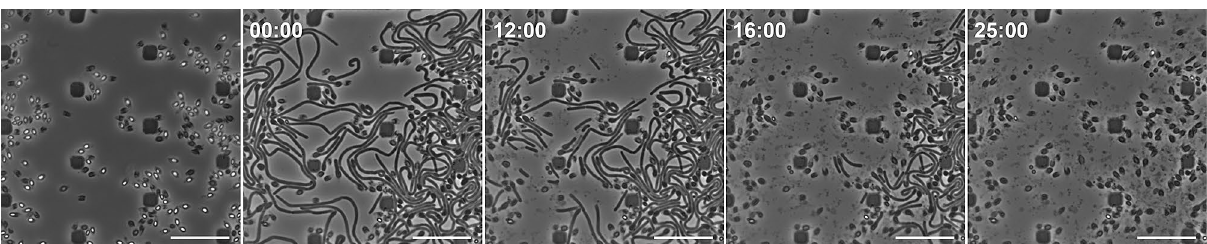
Figure 4. CBO1751 eliminates newly germinated cells of Clostridium botulinum ATCC3502 as analyzed by microscopy. First image from left, C. botulinum ATCC3502 spores in microfluidic chamber. Other images, representative time-lapse (min:sec) shots of cell lysing with 20 µM of CBO1751. Scale bars, 2 μm. Square-shaped dots are intrinsic pillars of the microfluidic